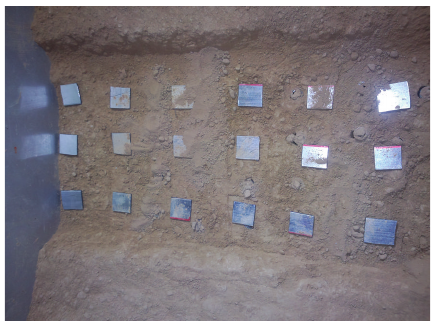
Figure 8: Finish of jacked pipe piles ( 𝑆/𝑑 = 4